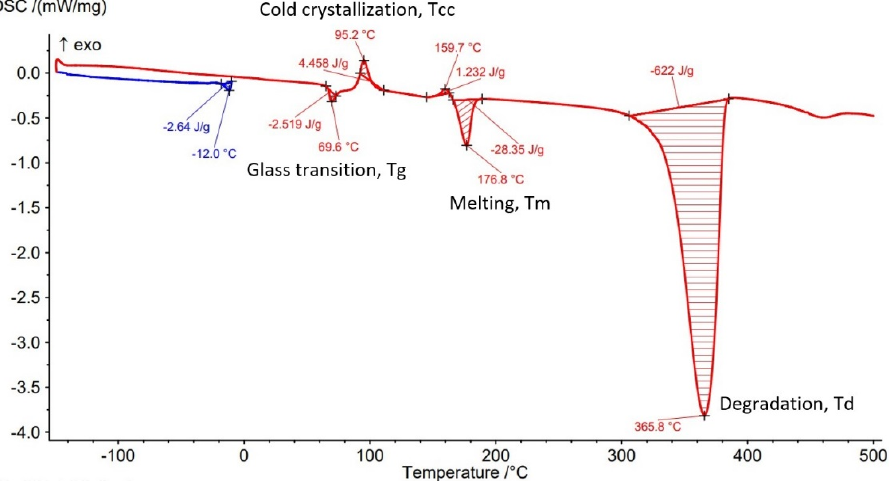
Figure 7. DSC curve for Filaticum PLA − GF filament.